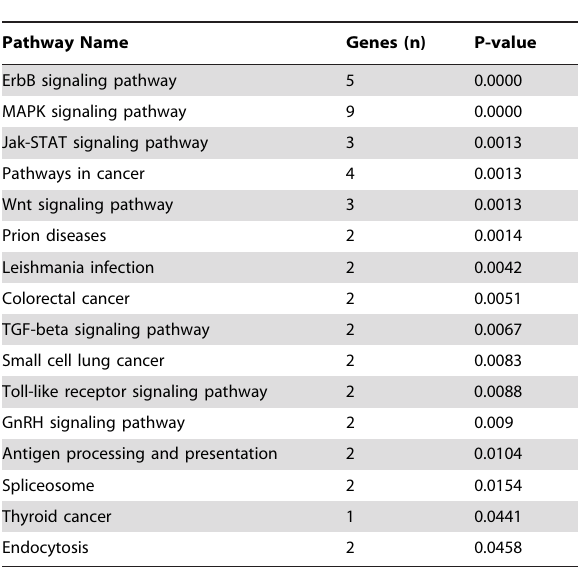
stretching for 1 h.